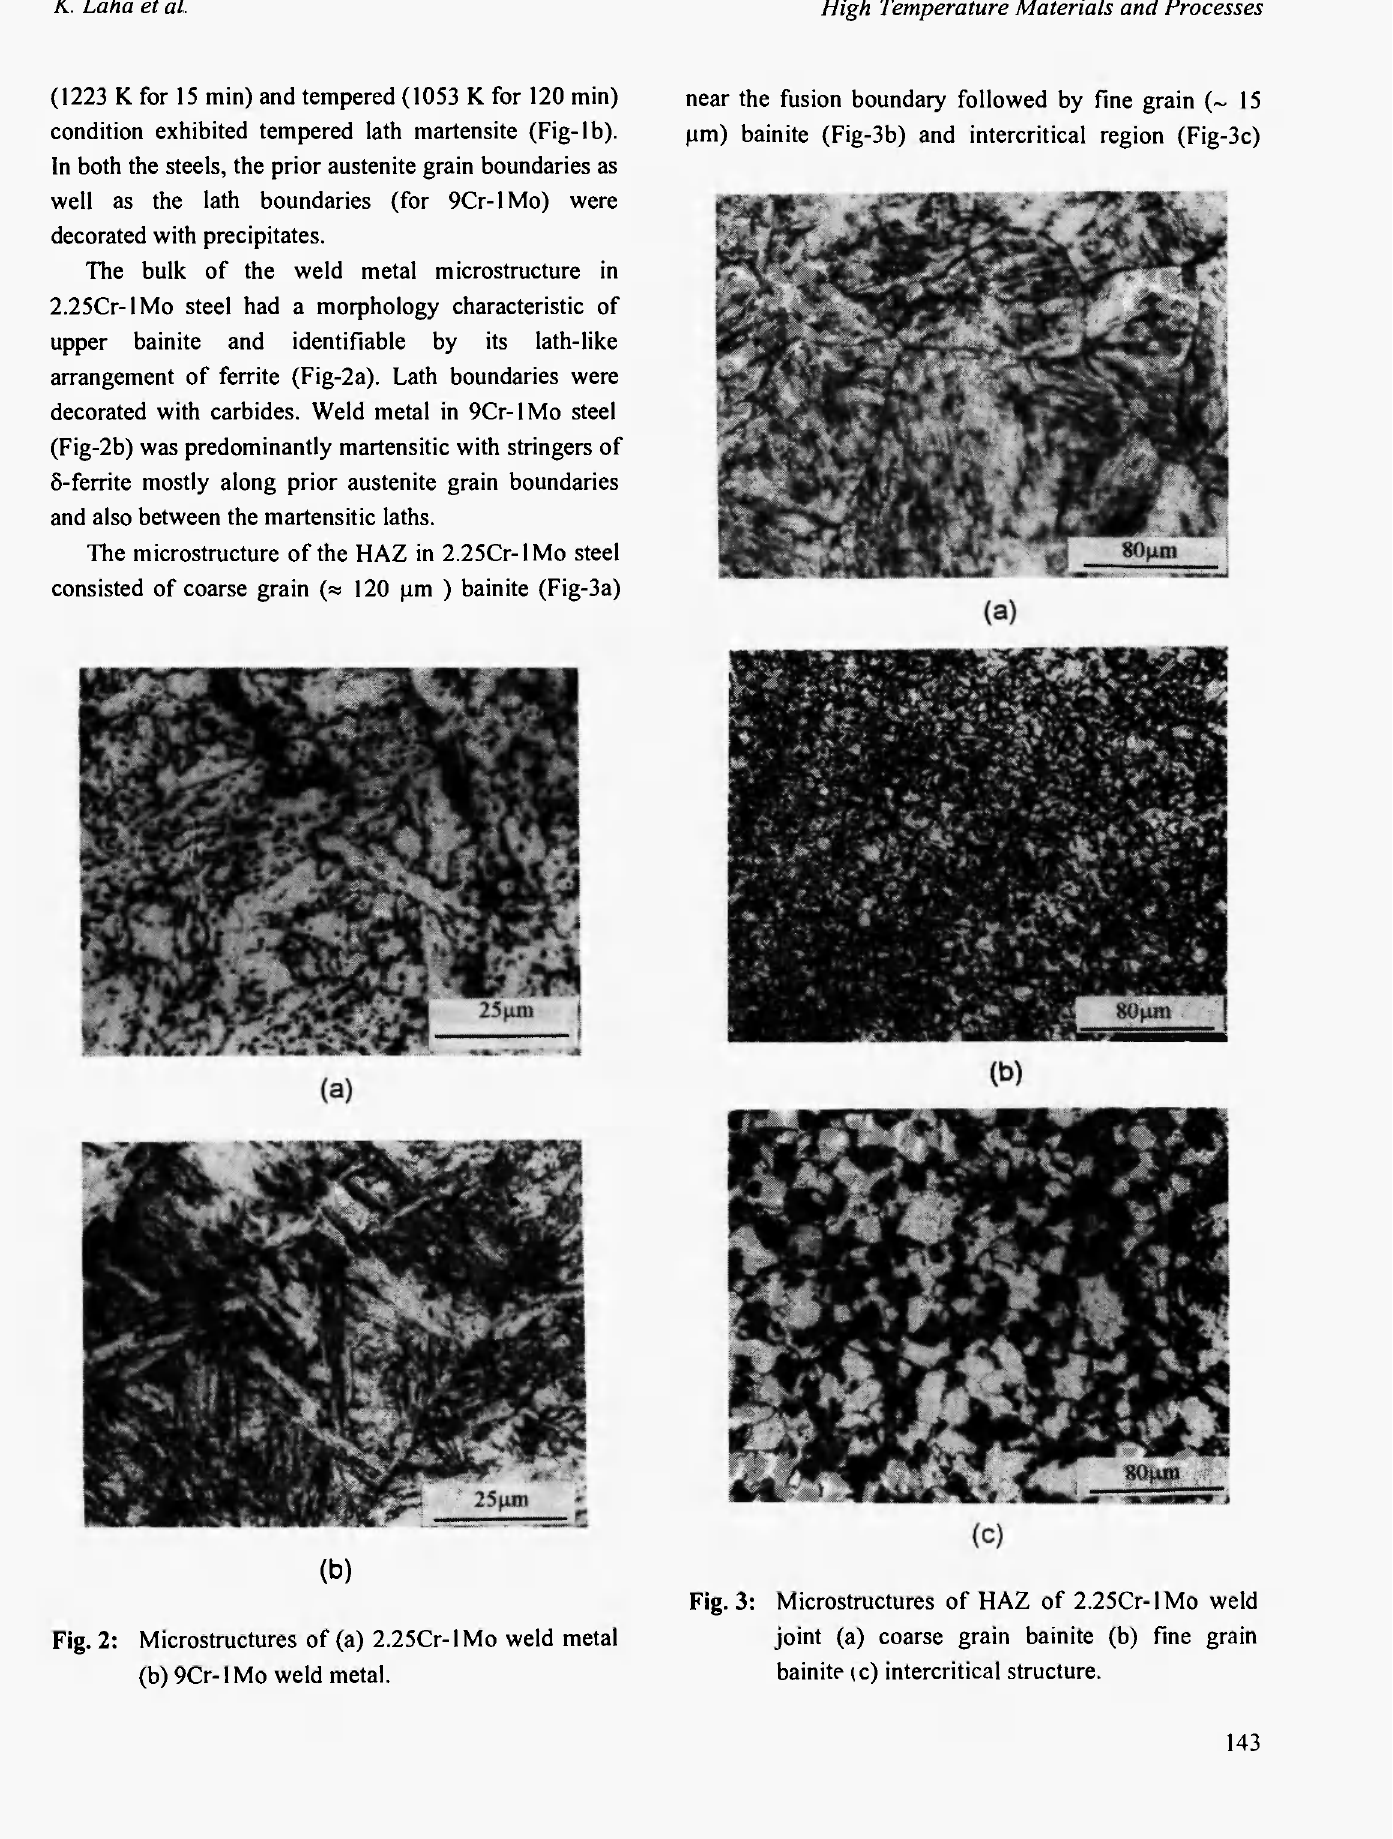
Fig. 2: Microstructures of (a) 2.25Cr-lMo weld metal (b) 9Cr-1 Mo weld metal.